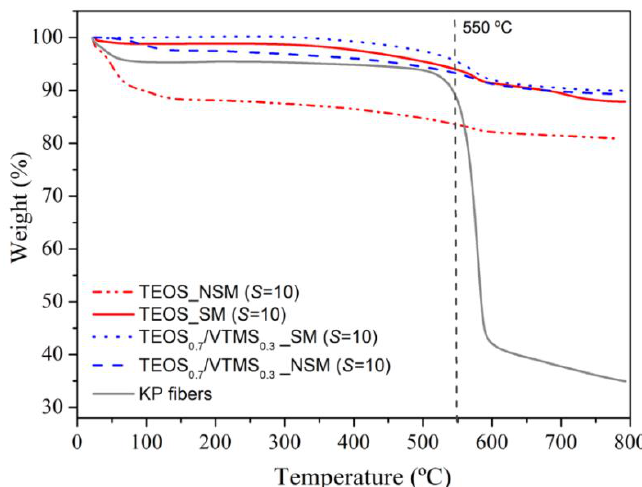
Figure 6. Thermograms for TEOS and TEOS 0.7 /VTMS 0.3 samples containing 5%wt. of KP, with surface modification (SM) and non-surface modified (NSM).